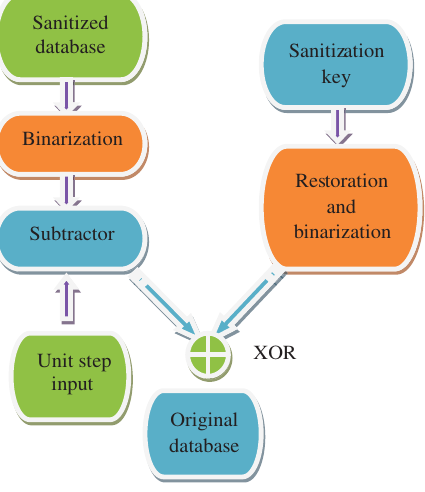
Figure 3: Restoration Process of the Proposed Data Preservation Algorithm. could be carried out by Eq. (12), in which ^ O indicates the restored data. The design of restoration process is given by Figure 3.